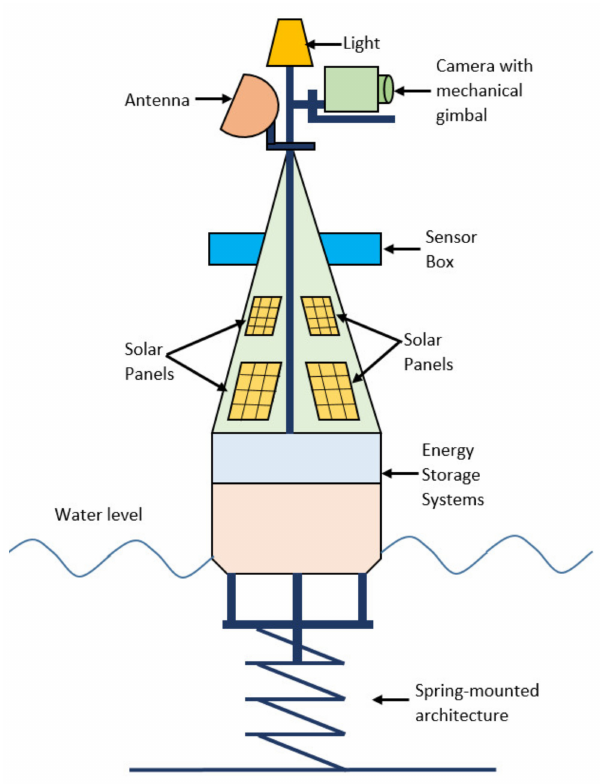
Figure 2. Components of the typical camera-based sensor integrated self-powered buoy for the proposed